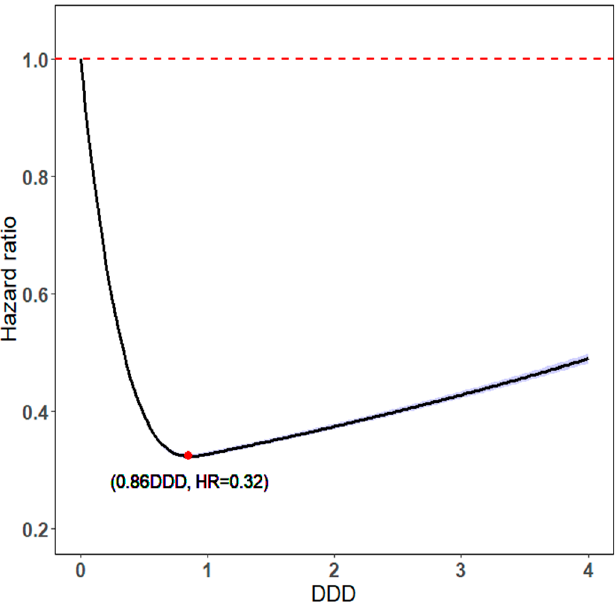
Figure 3. DDD of statin use vs. HRs for all-cause mortality.